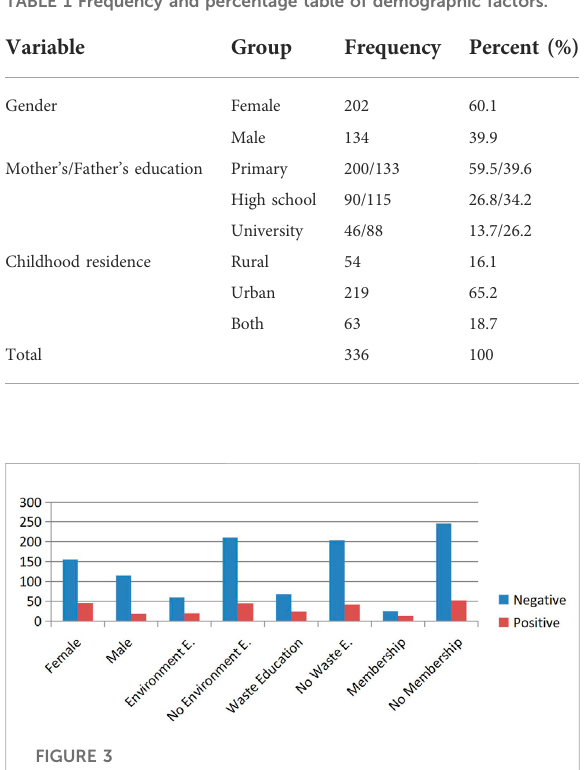
TABLE 1 Frequency and percentage table of demographic factors.